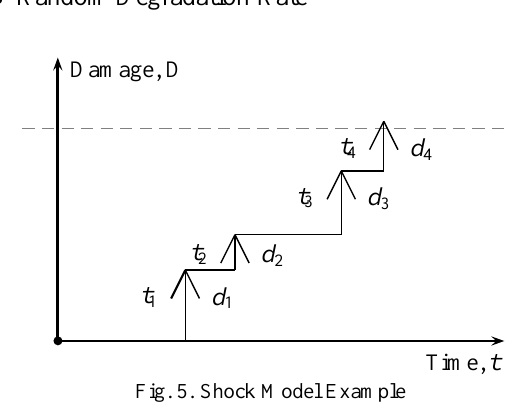
Fig. 5. Shock Model Example